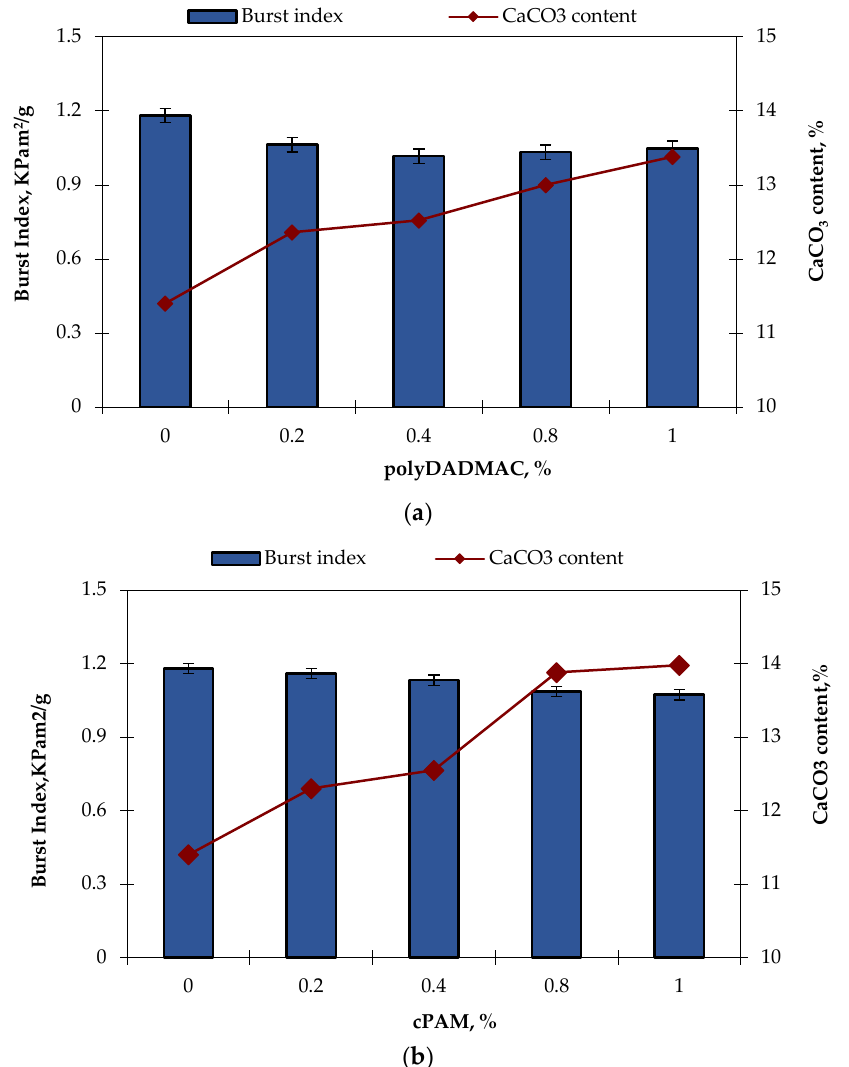
Figure 8. Influence of the addition of polyDADMAC ( a ) and cPAM ( b ) on the burst index of the paper.